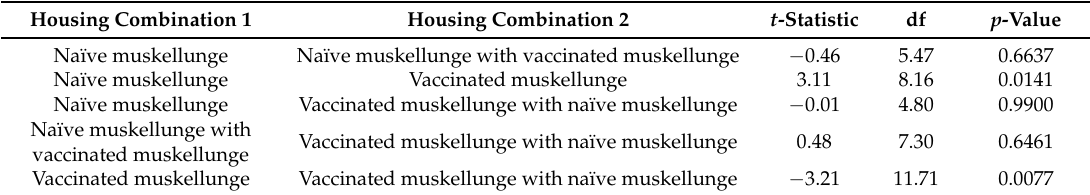
Table 6. Pairwise comparison of VHSV-IVb concentrations in survivors. Pairwise comparisons of percent positive VHSV-IVb detections in surviving muskellunge following viral exposure. The t -statistic, degrees of freedom, and p -value are shown for each